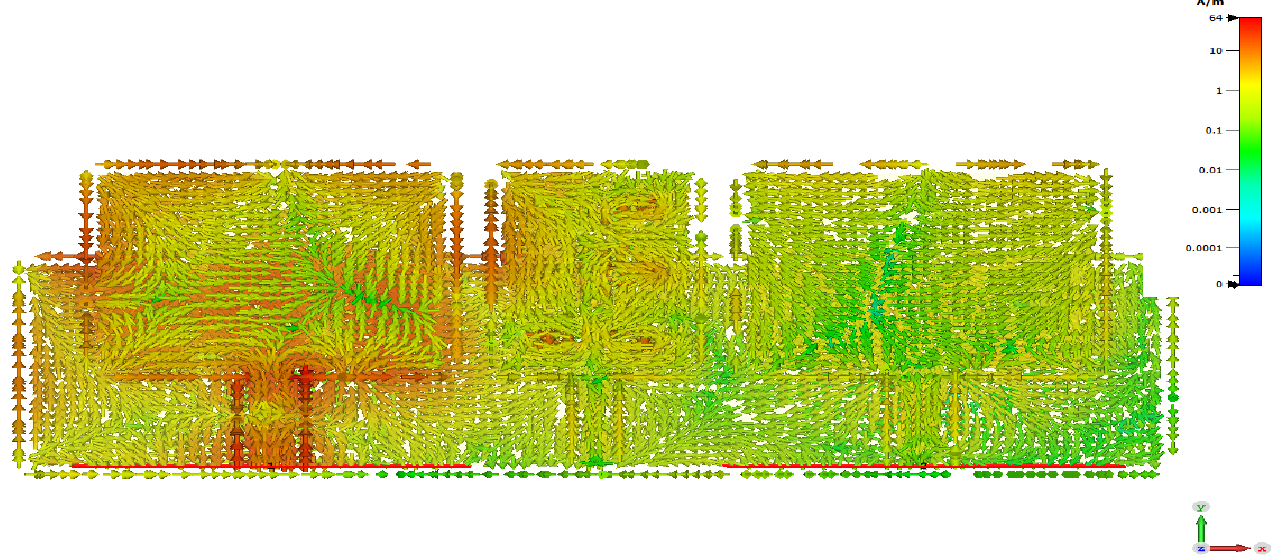
Figure 5. Current density of 2 × 1 microstrip patch antenna array with MTM-DS.